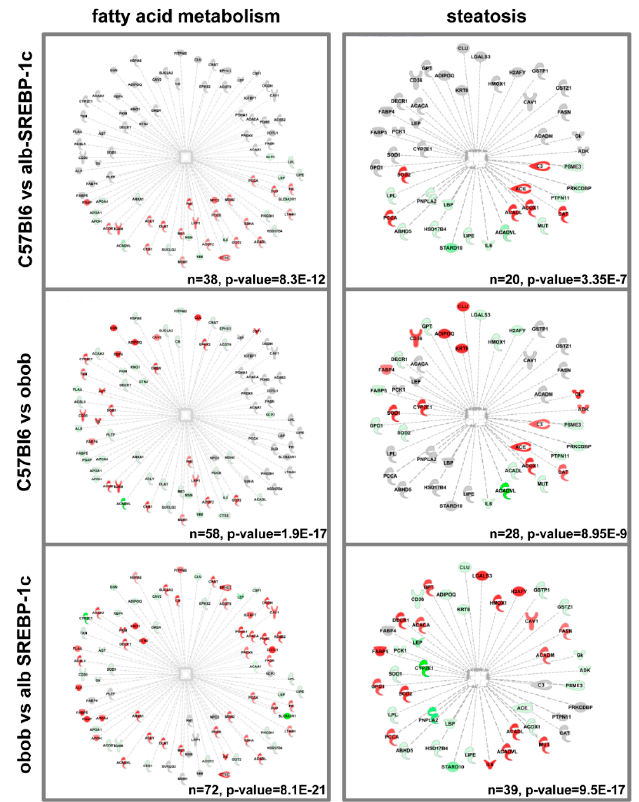
Figure 5. Differential enrichment of FA metabolism and steatosis-related proteins in the adipokinomes. The annotation of specific differentially abundant proteins to lipid metabolism or steatosis is shown. Data were analyzed with IPA ® core analyses (default settings). Coloring represents proteins with different abundances in the comparisons C57Bl6 vs. alb-SREBP-1c, C57Bl6 vs. obob, and alb-SREBP-1c vs. obob. (Red: more abundant; green: less abundant; grey: not regulated in the specific comparison).